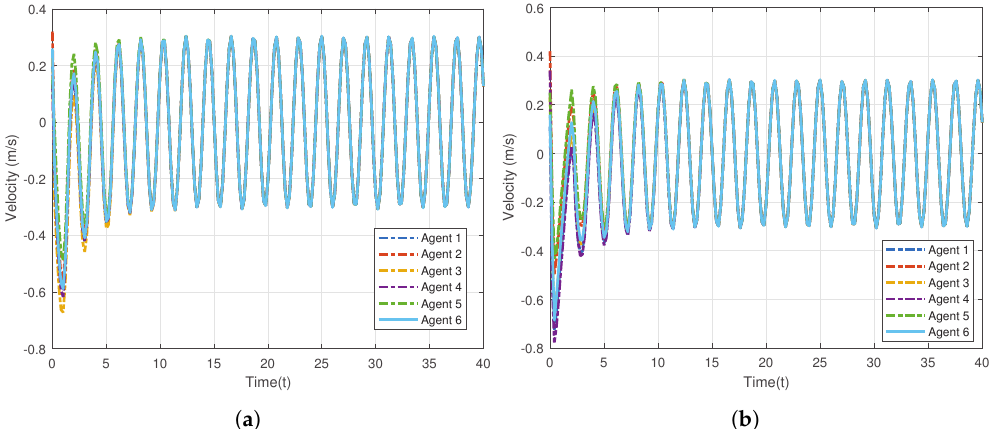
Figure 5. Velocities of 6 agents of the coupled Euler-Lagrange system. ( a ) Actual velocities on X-axis; ( b ) Actual velocities on Y-axis.